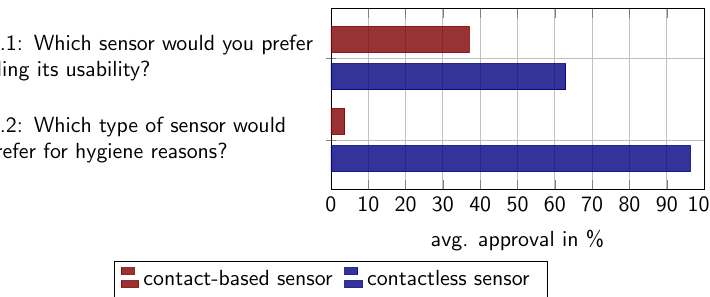
Figure 15. Comparative assessment of the capturing device type